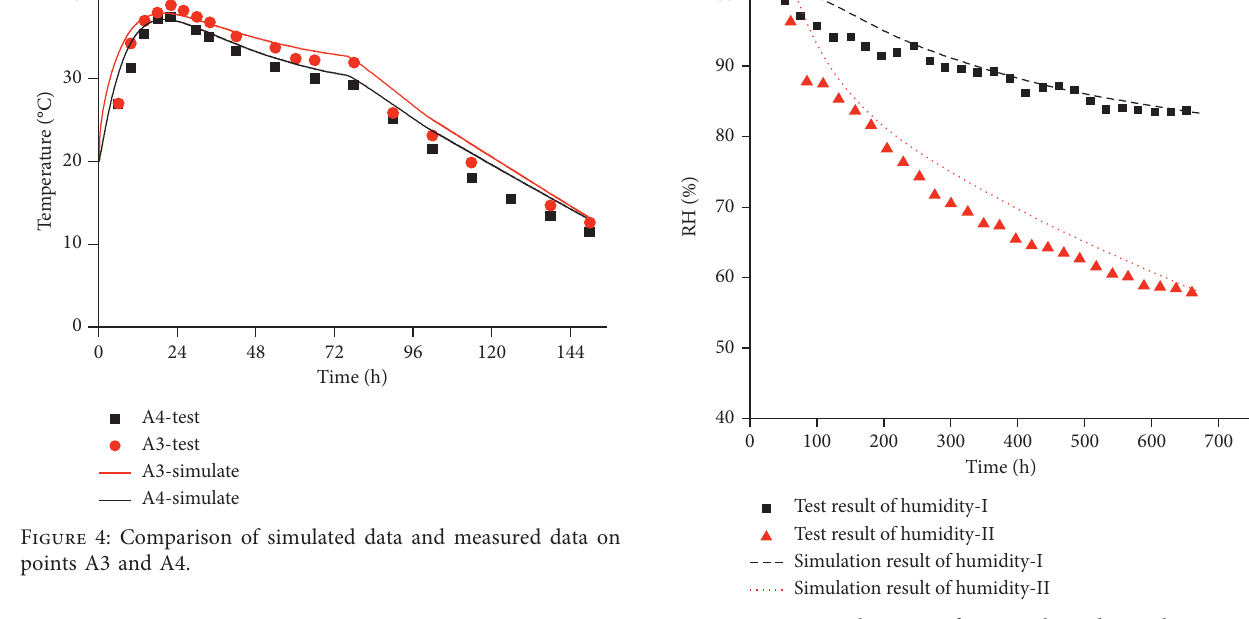
Figure 6: Development of interior humidity with age.